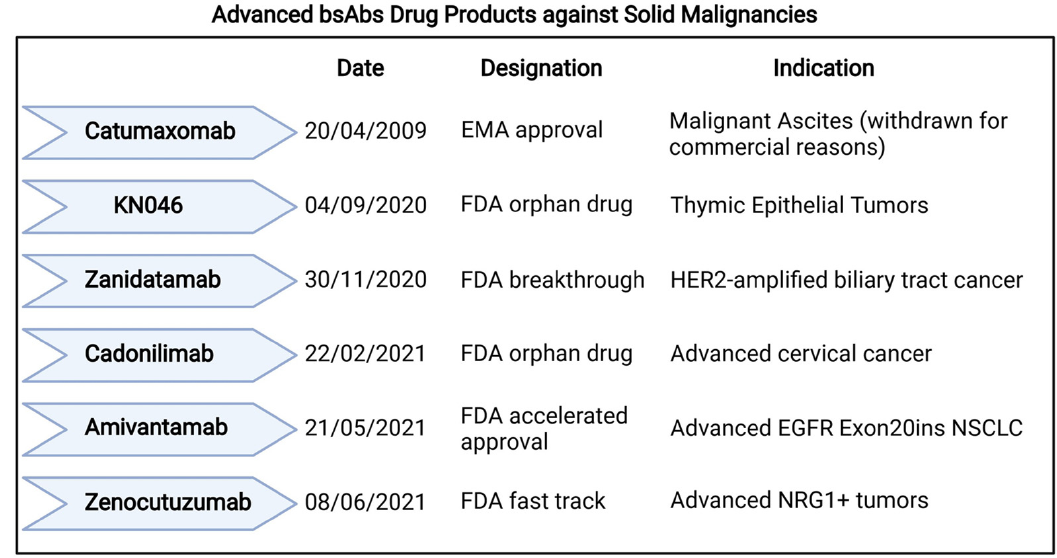
Figure 3. Advanced bsAbs Drug Products against Solid Malignancies. The figure depicts bsAbs receiving regulatory designations for their use in solid malignancies. Designations included, approval, accelerated approval, fast track, breakthrough, orphan drug. EMA, European Medical Agency; FDA, Food and Drug Administration; HER2, human epidermal growth factor; EGFR, Epidermal Growth Factor Receptor; NSCLC, Non-Small Cell Lung Cancer; NRG1, Neuregulin 1. Created with BioRender.com.